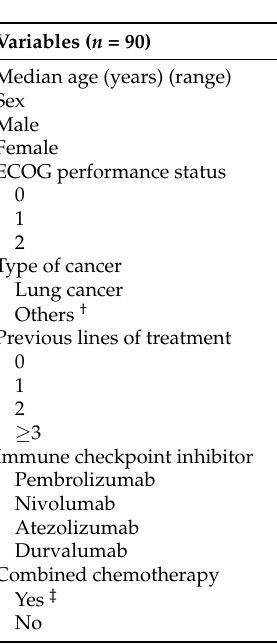
Figure 1. A flow chart of patient selection. Table 1. Baseline characteristics of patients.